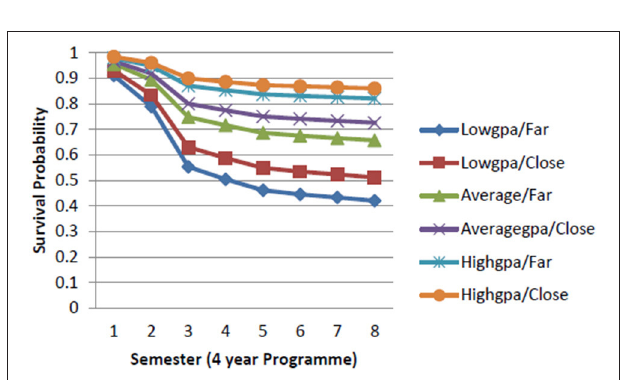
FIGURE 4 | Survival probability plots for the cumulative effect of academic vulnerability and proximity to family support on dropout over